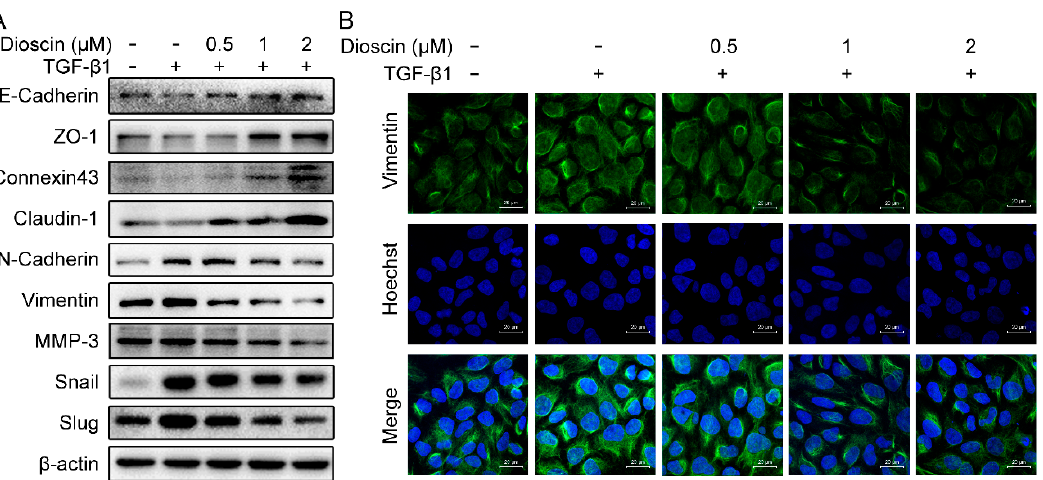
Figure 3. Effects of dioscin on expression of EMT markers. ( A ) Immunoblotting results. ( B ) Immunofluorescence of HepG2 cells; Vimentin is shown in green and nuclei are marked by DAPI stain. Cells were treated with 5 ng/mL TGF- β 1 for 24 h.